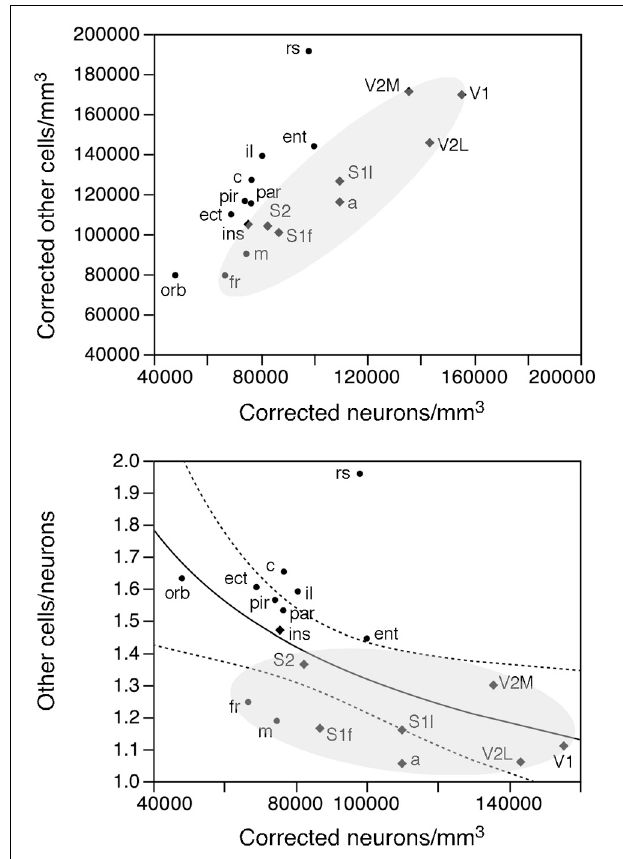
FIGURE 10 | Rules governing the distribution of other cells across cortical areas. Top, average density of other cells in each area plotted as a function of the average density of neurons in that functional area. There is a tight correlation between the two densities across functional areas divided into two clusters: one including the sensory and motor areas and motor cortex (shaded area) and another including the remaining cortical areas. Bottom, ratio between other cells and neurons (O/N) plotted as a function of the average neuronal density in each functional area. The fitted line is the power function of exponent − 0 . 330 that describes the entire